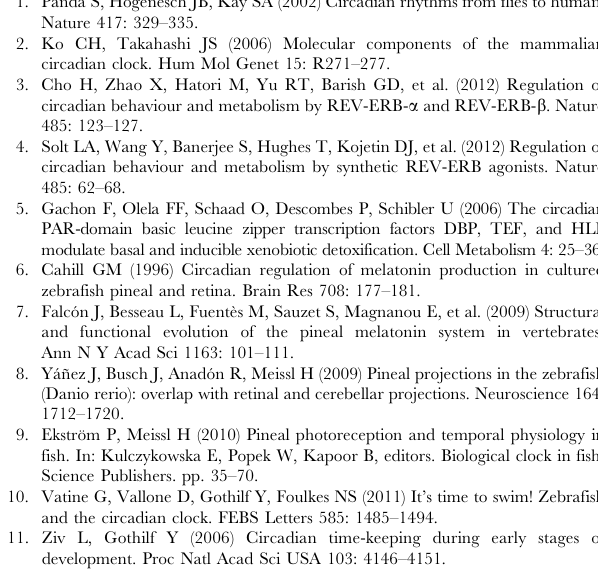
Figure S4 Locomotor activity levels under 3 dark flash stimuli. On day 6 post fertilization, control morpholino (solid line) and camk1gb morpholino (dashed line) injected larvae (n =24) were subjected to 3 dark flashes (black, gray and blue lines) of 5 sec each during the light phase. Activity was measured as the average distance moved in 1 sec time bins. Error bars represent SE (n =24). White and black horizontal boxes represent light phase and dark flash, respectively. Figure S5 Effect of camk1gb knockdown on the expression of known clock-controlled genes. Zebrafish embryos injected with either control morpholino (black bar) or camk1gb morpholino (gray bar) were subjected to DD during their third day of development and sampled at the peak and the nadir of their rhythm. Pineal mRNA levels of dec1, dec2, ndrg1l, sh3gl2 and opn1lw1 were determined by whole mount ISH. No statistically significant differences were observed (two-tailed t -test). Error bars represent SE (n= 10–15); CT= circadian time. Figure S6 The effect of camk1gb over-expression on the core clock marker per1b . The zebrafish photosensitive Pac-2 cell line were transiently co-transfected with camk1gb and per1b :luciferase constructs. Bioluminescence was monitored under LD and DD conditions. No significant differences were found in the reporter construct expression as a result of camk1gb over-expression. White and black bars show the light and dark periods, respectively. Grey bars represent subjective day. Figure S7 camk1gb expression in the adult pineal gland of transgenic zebrafish, Tg(aanat2:EGFP) Y8 . Double fluorescent in situ hybridization for egfp mRNA (A, green) and camk1gb mRNA (B, red) in adult pineal glands, reveals co-expression of camk1gb and the aanat2:EGFP transgene (C, merged image). Scale bar =10 m m. (TIF)